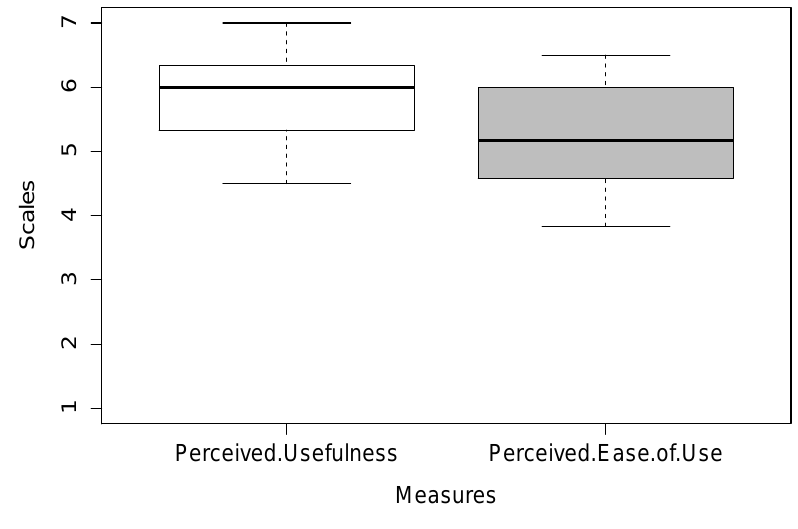
Figure 10. Perceived Usefulness and Ease of Use of our approach in